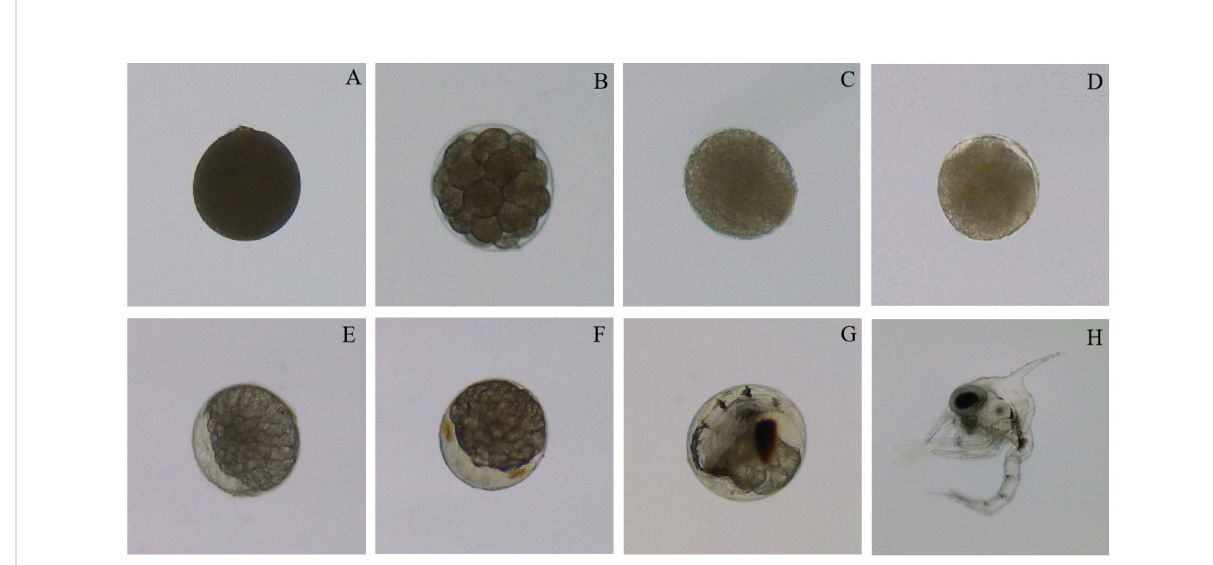
FIGURE 1 Embryonic development characteristics of swimming crab (A) : Zygote; (B) : Cleavage; (C) : Blastocyst; (D) Gastrula; (E) : Nauplius; (F) : Protozoea; (G) : Prehatching stage; (H) : Newly hatched